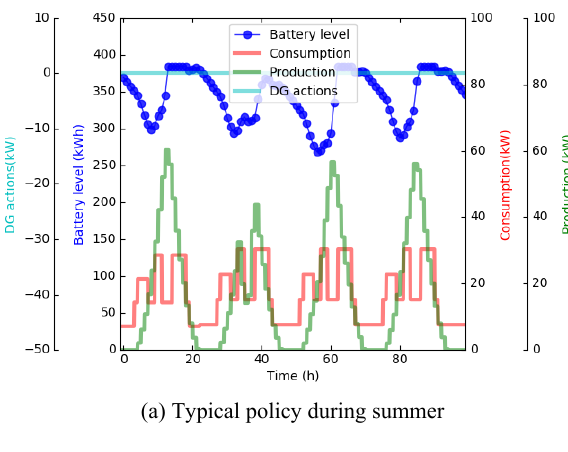
Fig. 16. Operational revenue 𝑀 𝑦 for the Case